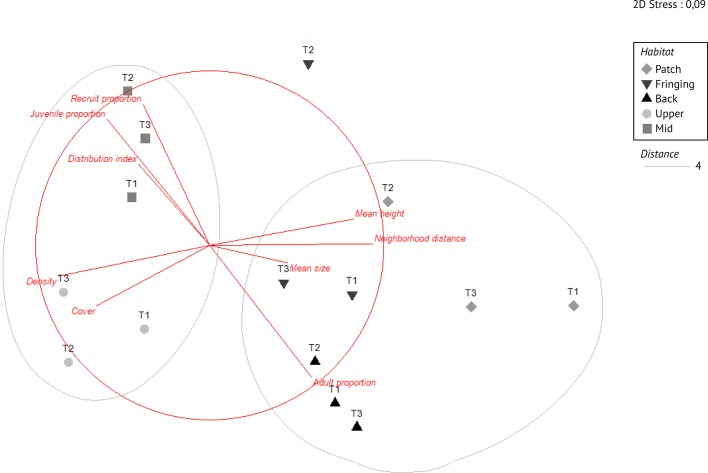
Non-metric multidimensional scaling (MDS) plot of Millepora platyphylla population structure across the five surveyed habitats.Different shapes indicate the three transects for each habitat and grey lines show clusters given by dendogram based on Eucledian distance of 4 at a stress level of 0.09. The surimposed red lines define the Eucledian distance coefficient on normalized data based on Spearman ranking, with each vector having lengths ≥ 0.4: density, cover, distribution index, mean neighborhood distance, mean height and size of adults, and proportion of recruits (< 1 cm2), juveniles (1–20 cm2) and adults (> 20 cm2). The second transect of the fringing reef is shown as a single group mostly related to a small population size (i.e. 27 colonies, S2 Table).